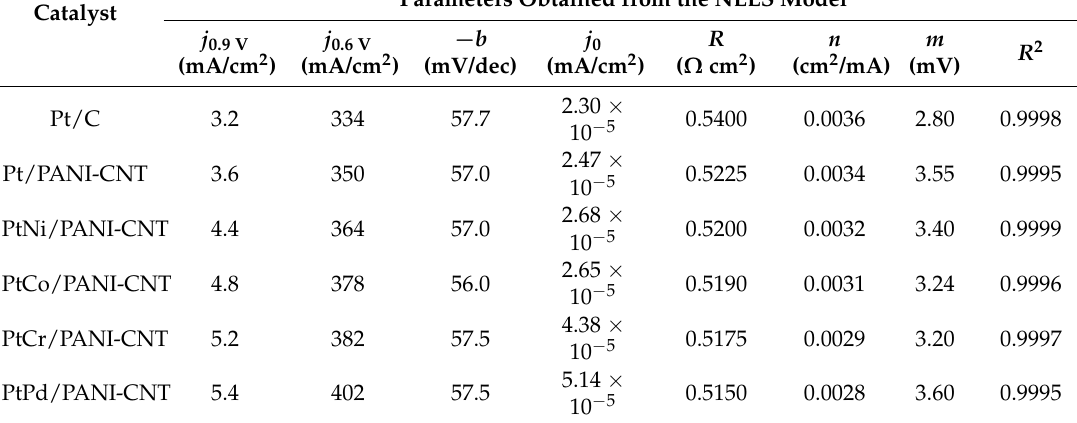
Table 3. ORR activity of the different catalysts in a PEM fuel cell under a H 2 /O 2 environment at 60 ◦ C and ambient